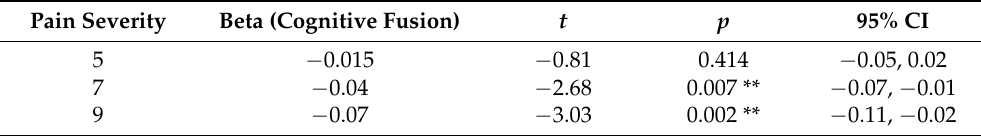
Table 3. Conditional effects of cognitive fusion on walking at values of pain severity. Pain Severity Beta (Cognitive Fusion) t p 95% CI 5 − 0.015 − 0.81 0.414 − 0.05, 0.02 −